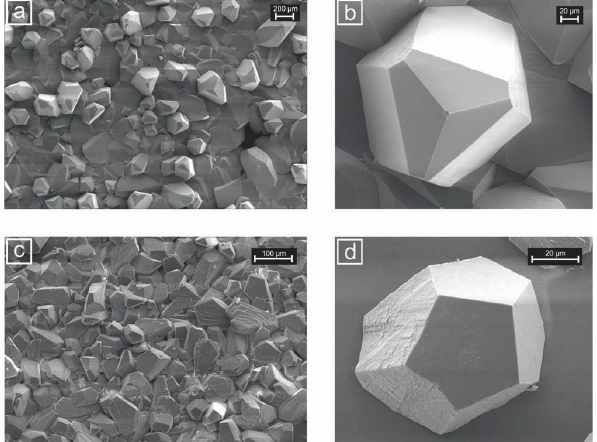
Fig. 6. (a) Crystals (precipitated in the pool, locality 6, Fig. 4b) with acute rhombohedral faces on the flanks and obtuse rhombohedral faces at growth end. (b) detailed view of a single crystal shown in a). (c) Calcite crystals grown on watch glass, placed on top of stalagmites in Bunker Cave (Riechelmann; 2010). (d) detailed view of a single crystal shown in c).